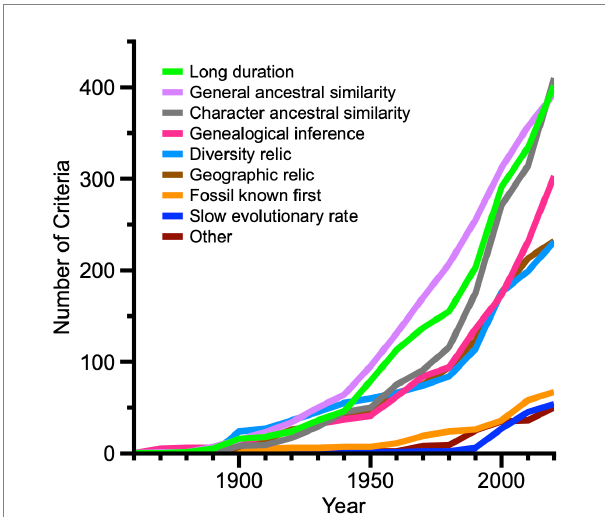
FIGURE 8 Line graph showing relative changes in criteria for assigning living fossil status among 853 unique living fossil entity names from 1860 to 2020. Note that many authors have used more than one criterion or indication for a given taxonomic or non-taxonomic entity. A given entity may be designated in several publications; after the earliest publication, unique additional criteria for that entity are recorded in relevant later years, but subsequent duplicate criteria are